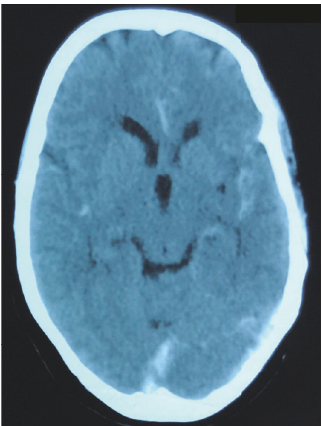
Figure 1: Preoperative plain Computed Tomogram scanof the brain showing subarachnoid hemorrhage.